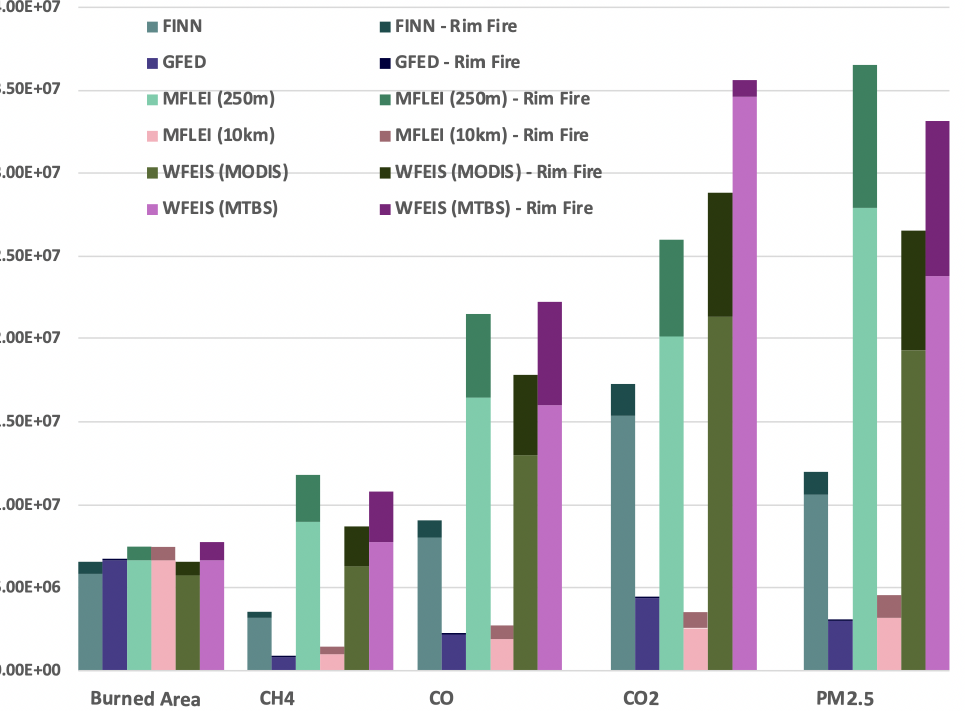
Figure 2. Burned area and emissions from each emissions inventory for 2013, with the top, darker color indicating the Yosemite Rim Fire emissions. For GFED, the Yosemite Rim Fire emissions are so much lower than the yearly emissions that the darker color cannot be discerned. Because each inventory reports drastically different emissions estimates, each category needed to be scaled differently to represent them all on the same graph. Burned area is reported in m 2 , while all chemical species are reported in grams. Burned area is scaled by 10 − 3 , CH 4 is scaled by 10 − 4 , CO is scaled by 10 − 5 , CO 2 is scaled by 10 − 6 , and PM 2.5 is scaled by 10 − 5 . The y-axis is represented linearly with a break at